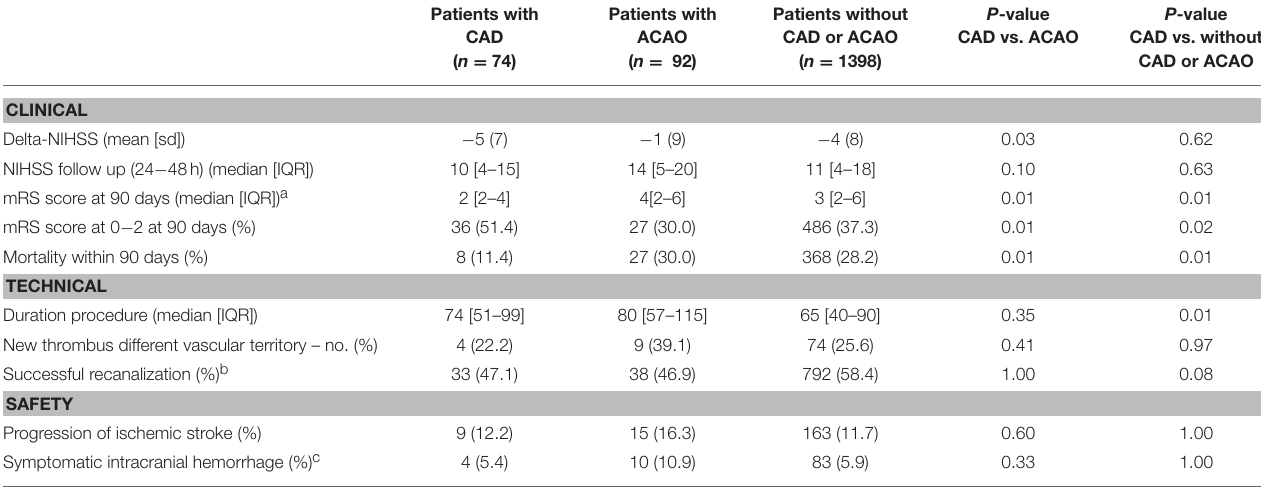
P -value CAD vs. ACAO